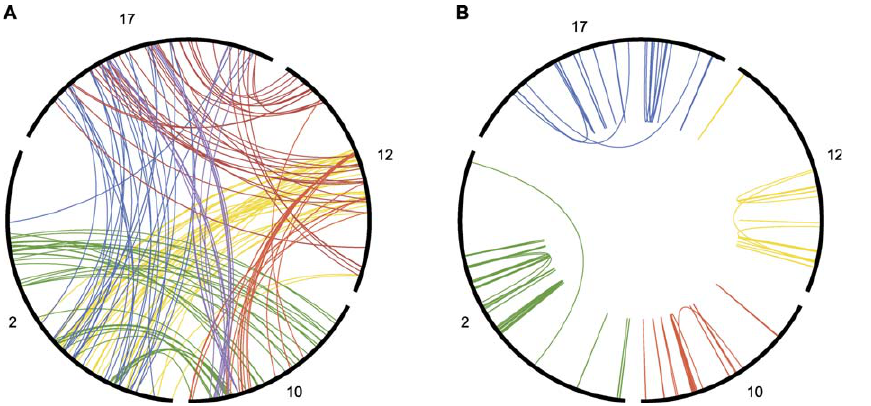
Figure 7. An Arbitrarily Selected Subset of the Human Genome Showing the Physical Relationships Among Paralogous Genes (A) This is an example of the tetra-paralogous relationships of a subset of human genes that are all inferred, by gene trees, to have duplicated prior to the split of fish from tetrapods, but after the split of Ciona from vertebrates. These genes are on four chromosomes with their identities indicated outside of the circle. The complete set of tetra-paralogons can be viewed in Figure S3. (B) In contrast, paralogous human genes generated by duplications after the split of fish and tetrapods, as shown for this sample of the same four human chromosomes, do not form such tetra-paralogons. Their pattern appears to result from smaller-scale tandem duplications of individual genes or segments, followed by slow rearrangements. In addition to these apparently functional gene pairs shown in the figure for this portion of the human genome, we have identified eight pseudogene pairs that occur on different chromosomes; it is not clear whether these pseudogenes are the result of random retrotransposition (or other rearrangement mechanisms) rather than gene conversion events between older duplicates, which would make it appear as though these had duplicated later than they actually did, as has been observed in yeast [29]. DOI: 10.1371/journal.pbio.0030314.g007 PLoS Biology |